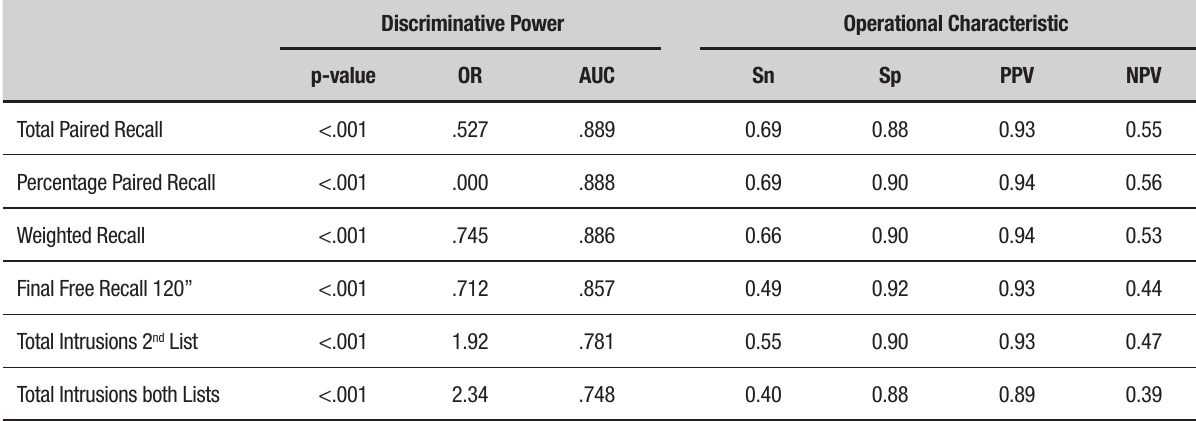
Table 2. MBT: Operational characteristic and discriminative power.